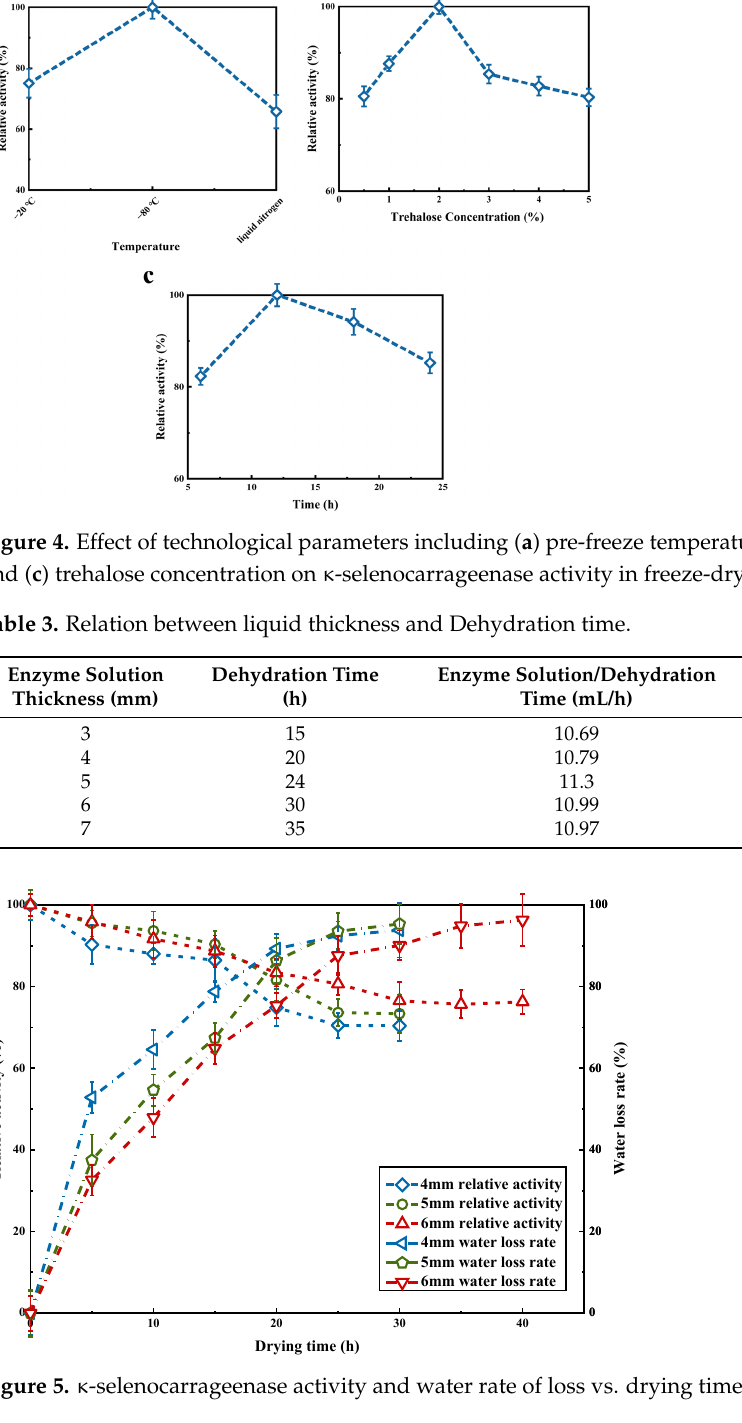
Figure 5. κ -selenocarrageenase activity and water rate of loss vs. drying